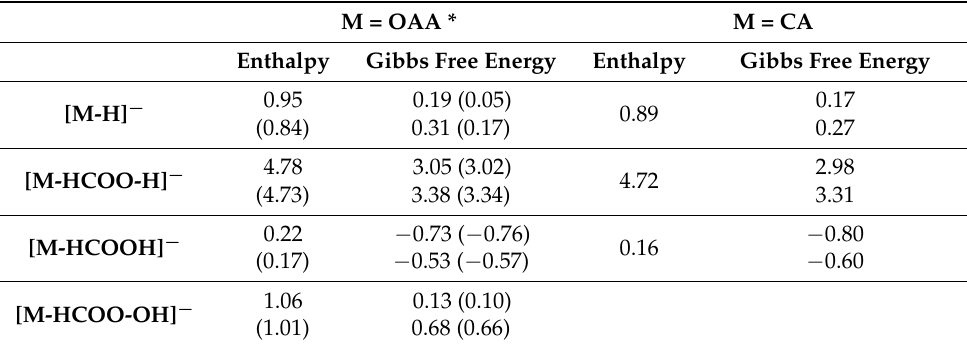
Table 2. Calculated fragmentation thresholds (DFT level of theory) of cis-enol oxaloacetic (OA) and citric (CA) acids: enthalphy (0 K) and Gibbs free energy at the ω B97x/aug-cc-pvtz level at 400 K. Energies in eV. * Values for trans-enol OAA are given in parentheses. The values in red are Gibbs free energies calculated at 298 K. M = OAA * M = CA Enthalpy Gibbs Free Energy Enthalpy Gibbs Free Energy 0.17 0.95 0.19 (0.05) [M-H] − 0.89 (0.84) 0.31 (0.17)